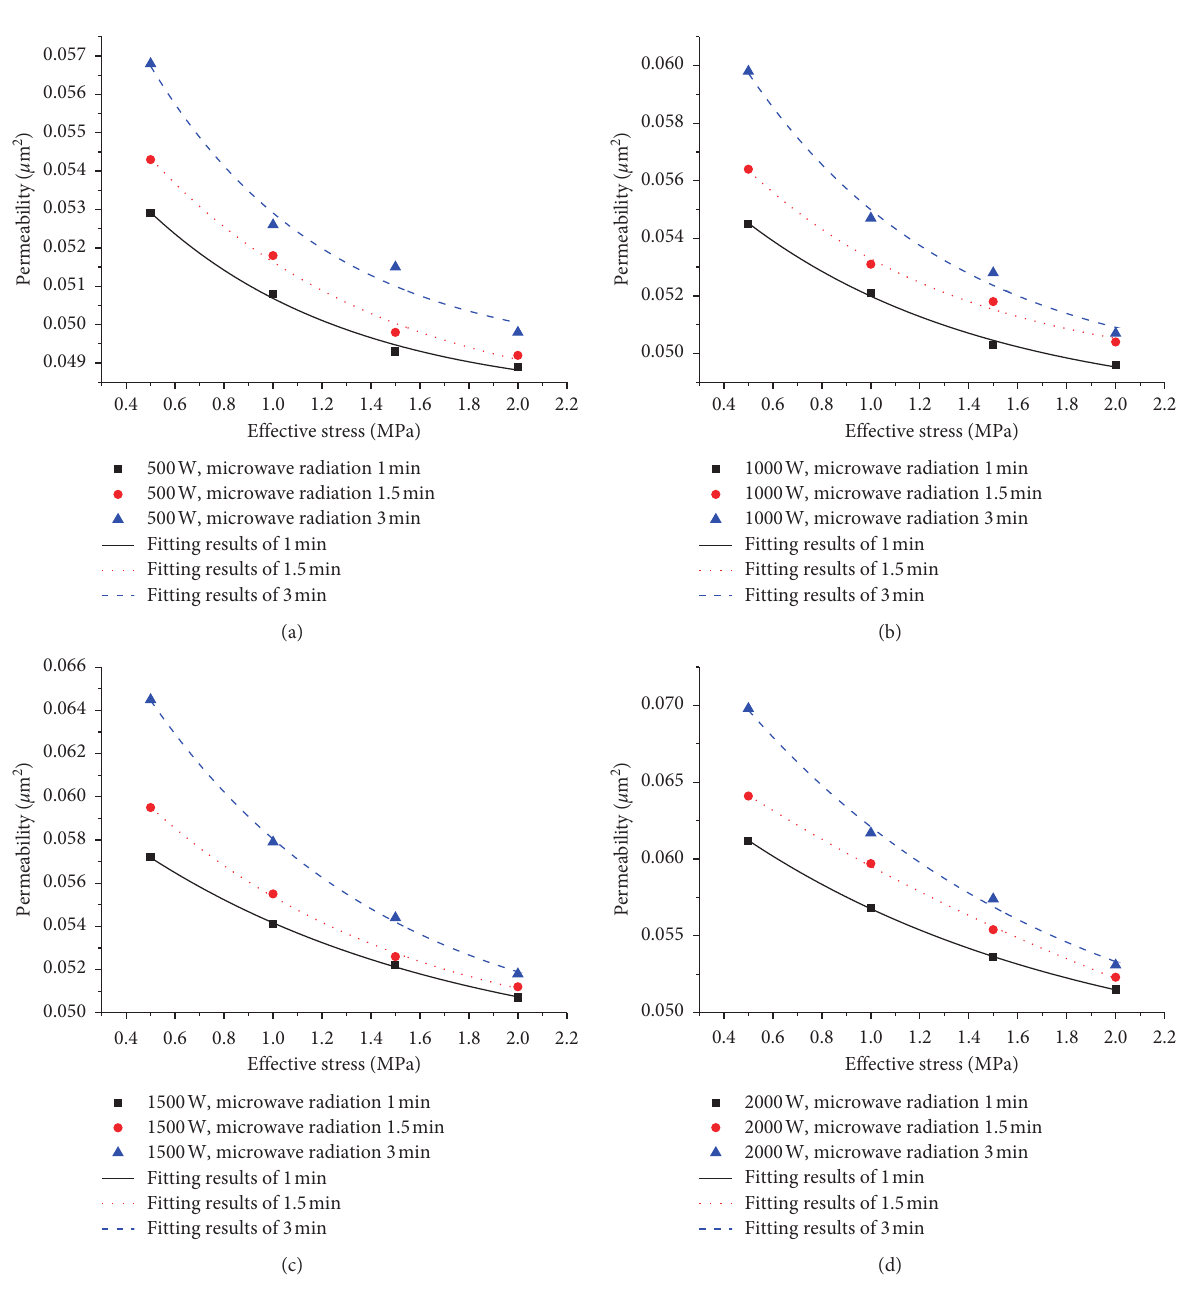
Figure 3: Changes in permeability with irradiation time at a confining pressure of